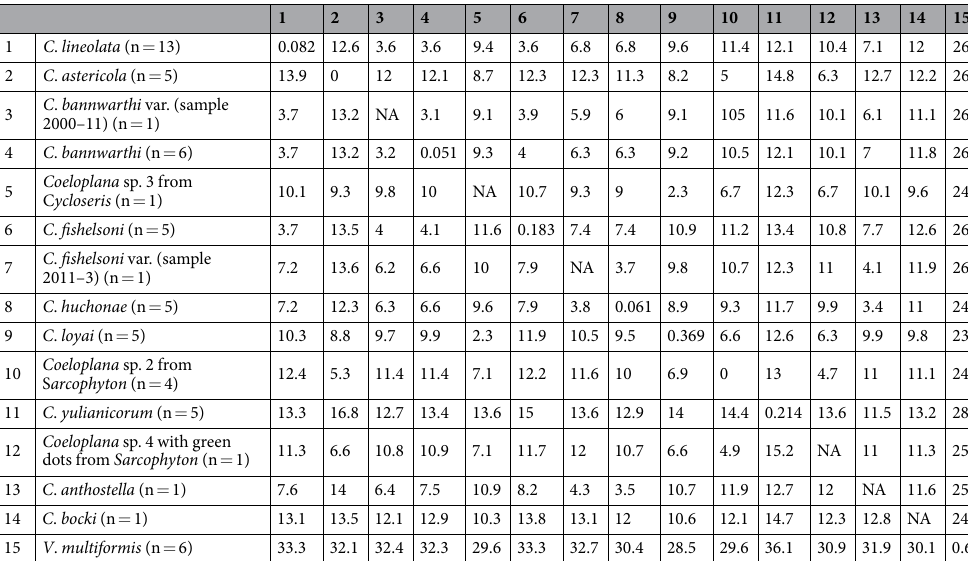
Table 4. COI intra- and interspecific sequence divergence (K2P distances/ p -distances) for ctenophore species from the family Coeloplanidae. Below diagonal: interspecific K2P divergence; Above diagonal: interspecific p -distances; Diagonal: Intraspecific genetic divergence marked in bold font (K2P and p -distance gave similar results). The number of specimens considered for each species is indicated near the sample